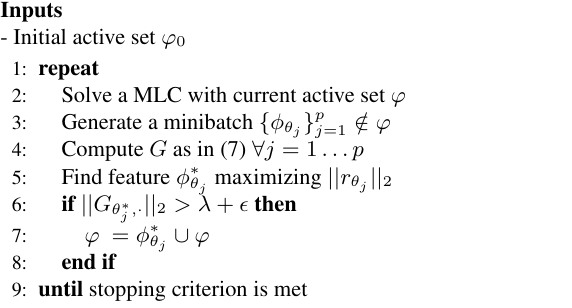
Algorithm 1 Multiclass active set selection for